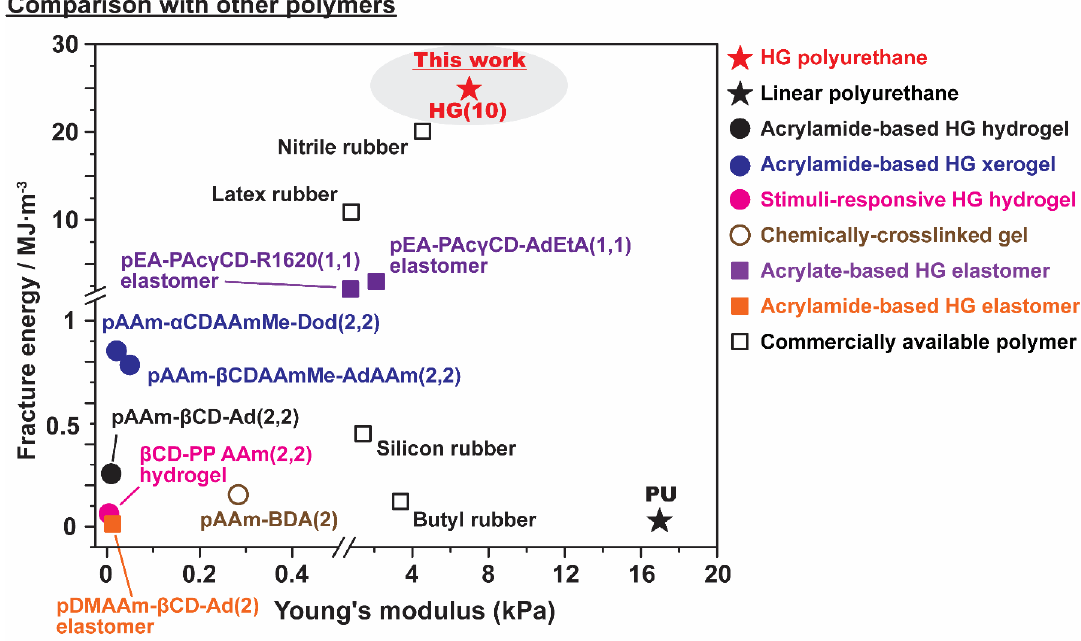
Figure 6. Comparison of the mechanical properties of HG(10) with other polymers. Materials represented by star symbols ( ★ ) are the TPUs prepared in this work (red-labeled material is HG(10) and black-labeled material is PU), the materials represented by dots ( • ) are hydrogels (black-labeled materials from reference [63], blue-labeled materials are from reference [64], and pink-labeled materials are from reference [65]), the materials represented by brown-labeled hollow dots ( ○ ) is a chemically cross-linked hydrogels, materials represented by square symbols ( ■ ) are elastomers (purple-labeled materials are from reference [49] and orange-labeled materials are from reference [50]), and materials represented by black-labeled hollow square ( □ ) are commercially available polymers.